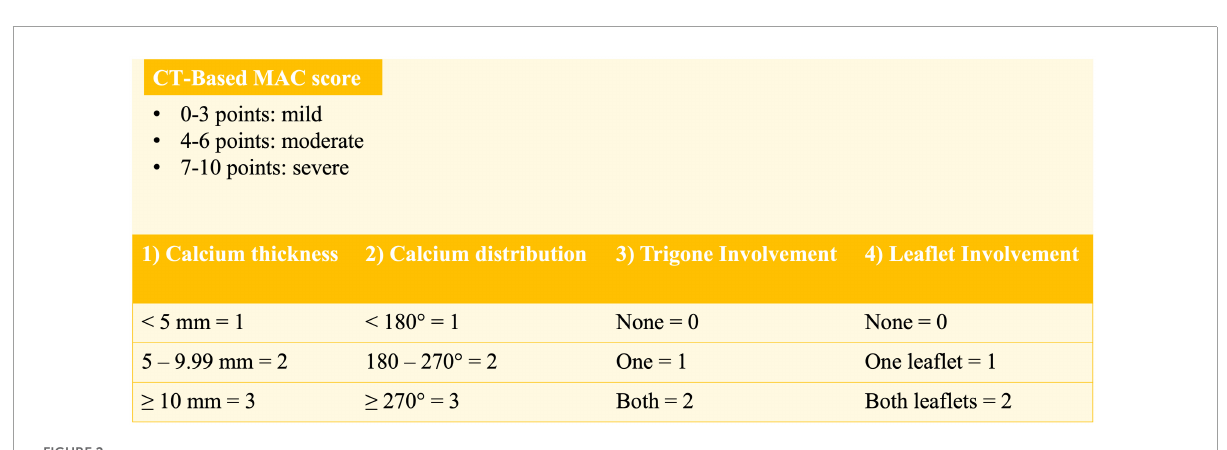
FIGURE2 Computed tomography (CT)-based mitral annular calcification (MAC) score according to Guerrero et al.